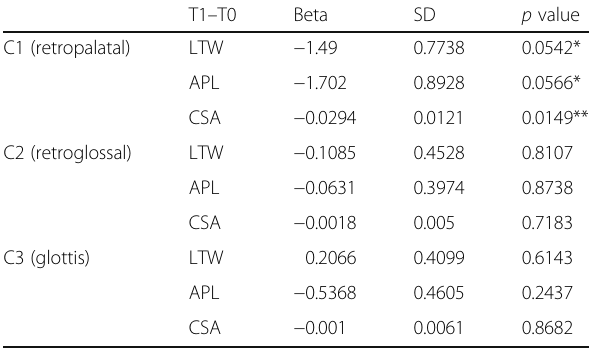
Table 4 Correlation between changes of airway configuration and snoring